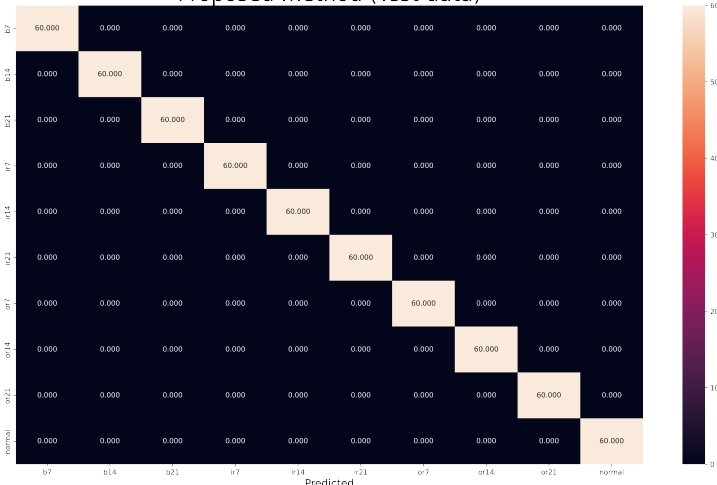
Figure 8. Confusion matrix of test